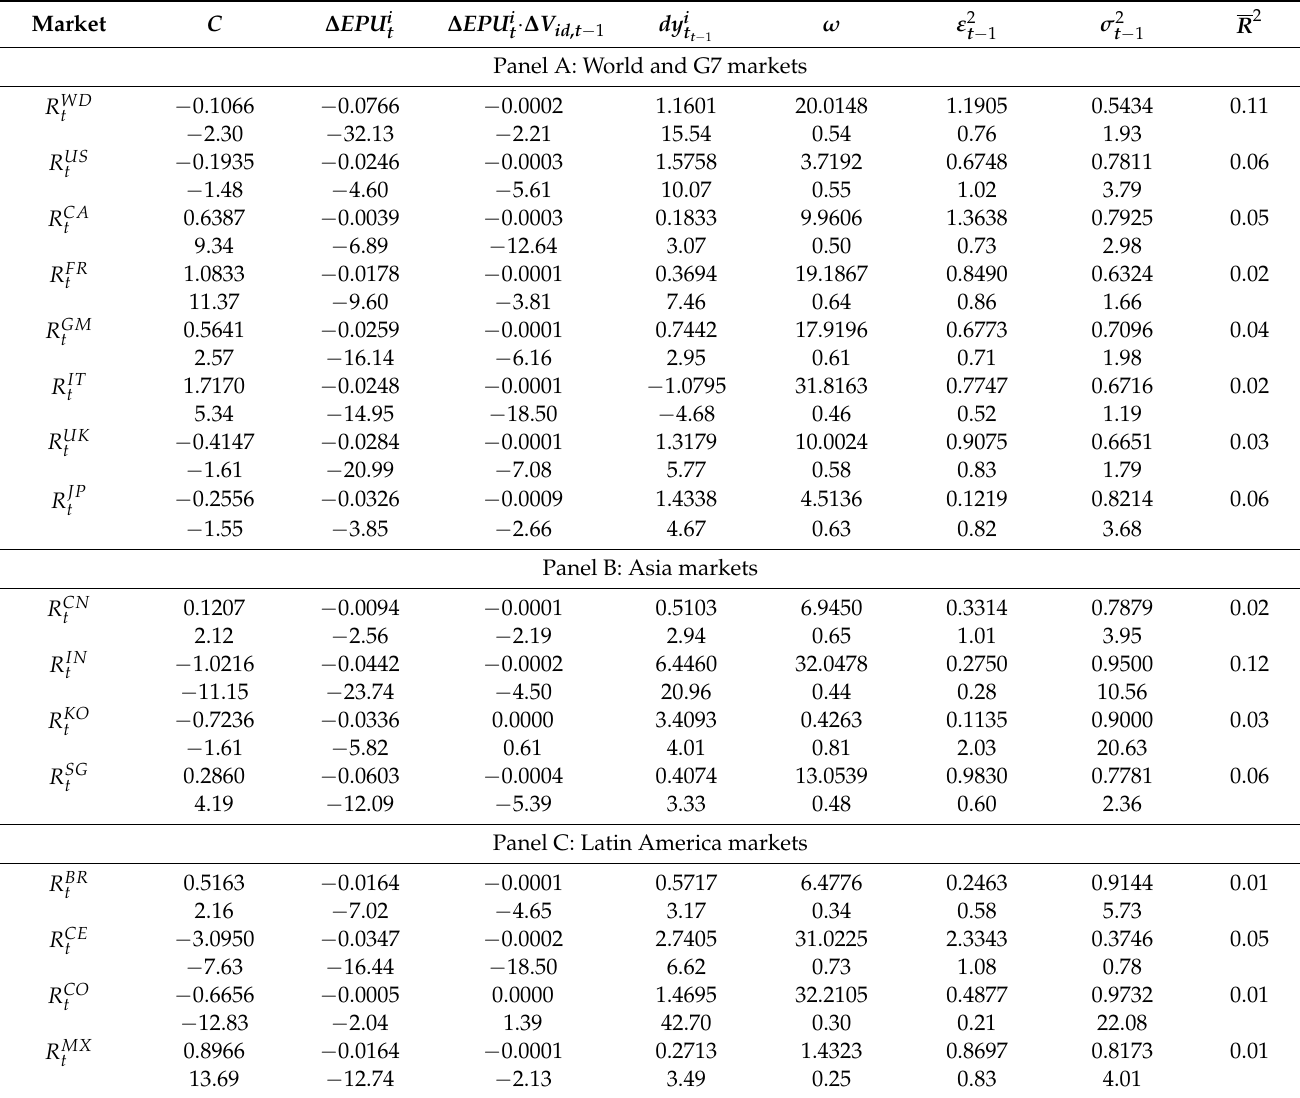
Table 6. Estimates of stock returns in response to change in economic policy uncertainty and its reaction to change in infected disease